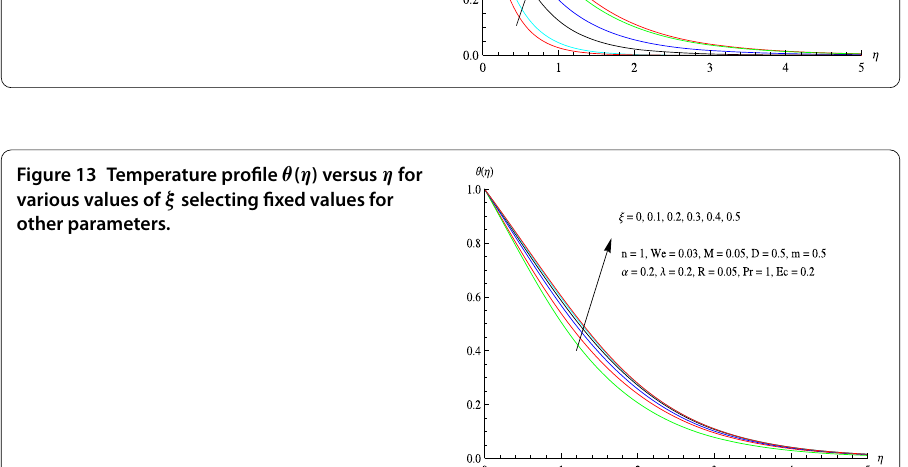
Figure 13 Temperature profile θ ( η ) versus η for various values of ξ selecting fixed values for other